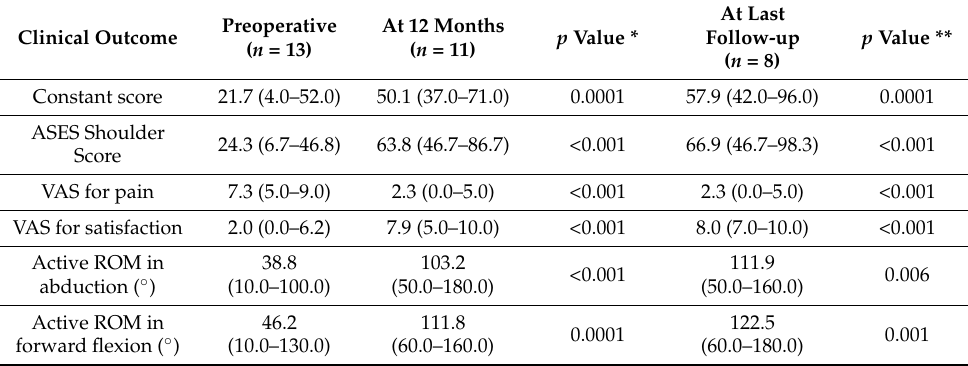
Table 2. Clinical